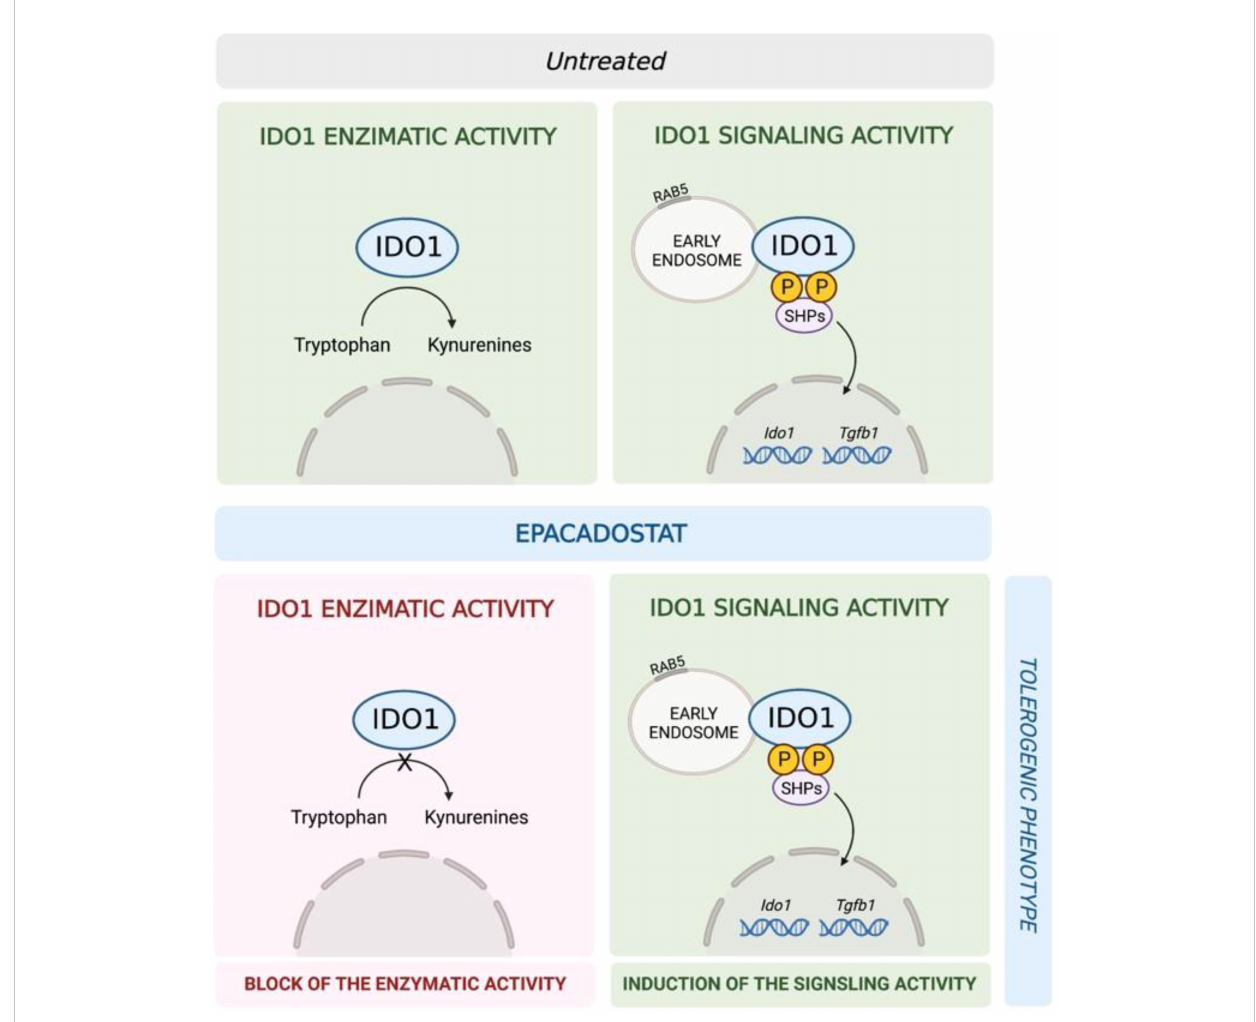
FIGURE 5 Schematic representation of the epacadostat effects on IDO1 in pDCs. In untreated pDCs ( upper panel ) IDO1 is capable to perform both the enzymatic and the signaling activity. Epacadostat ( lower panel ) inhibits the IDO1 enzymatic activity but enhances IDO1-mediated signaling events, thus resulting in the induction of a tolerogenic phenotype in